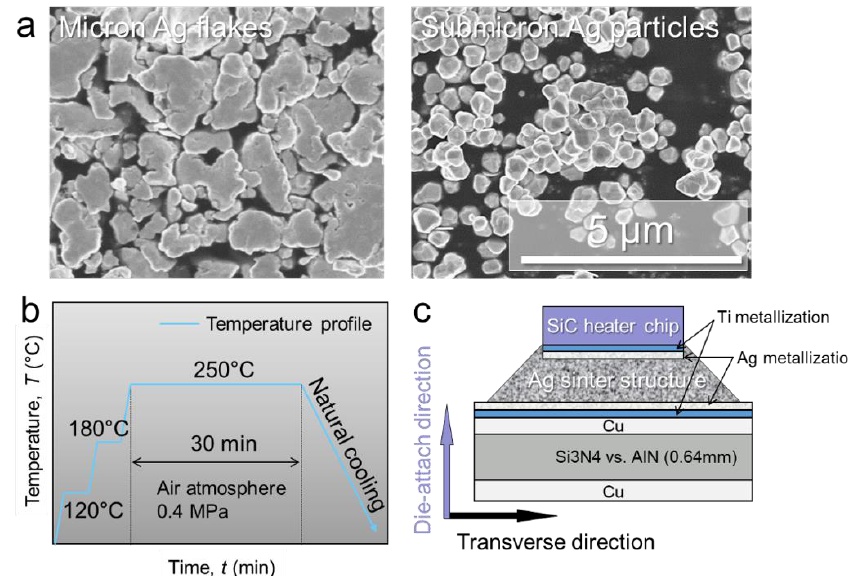
Figure 3. ( a ) Ag particles, ( b ) sintering condition and ( c ) schematic diagram of the assembled